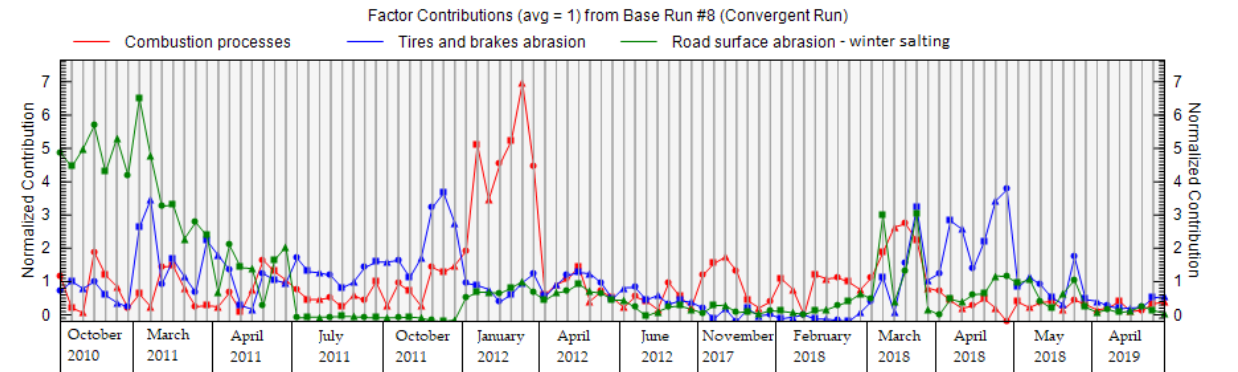
Figure 11. Contribution of factors during individual periods of PM 2.5 measurements in the city of Žilina.